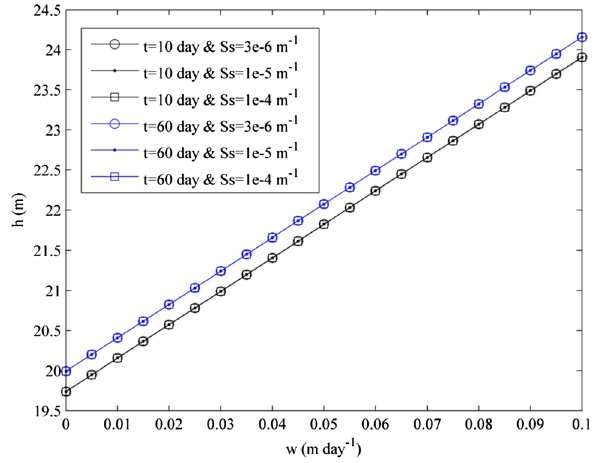
Fig. 10 Variation in hydraulic heads due to changes in recharge rate with different values of